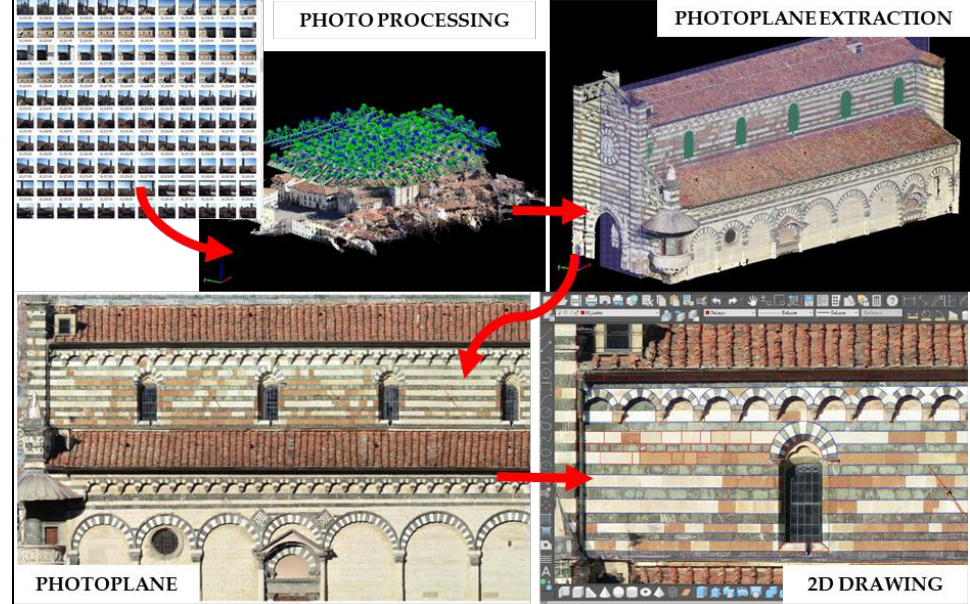
Figure 3. Workflow from elaboration of the photoplanes to the drawing in CAD.